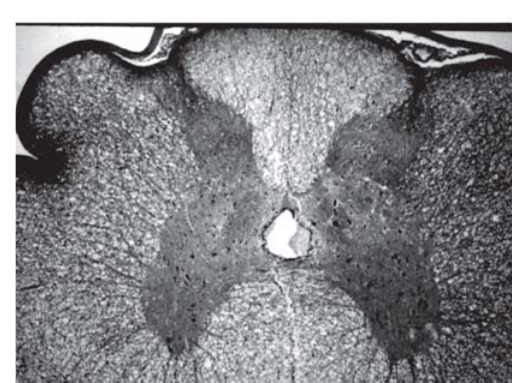
Fig. 5 - Animals with grade III injury (complete widespread neuronal necrosis)